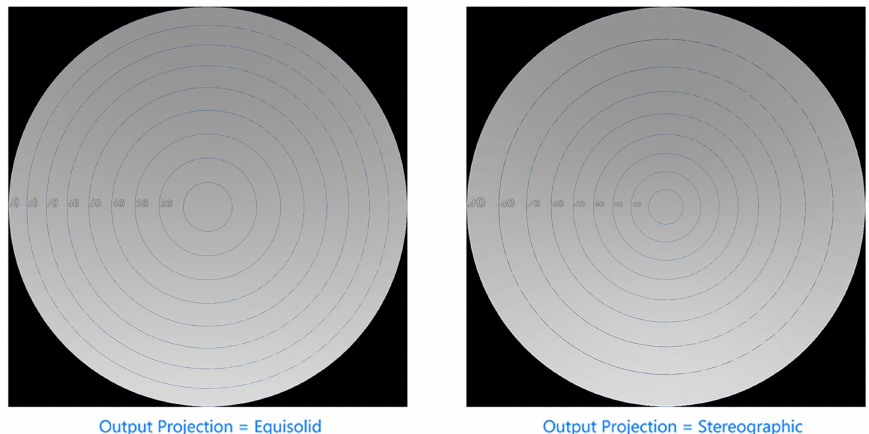
Figure 17. The original benchmark image on the left and the remapped image to hemispherical projection on the right (Source: the authors).